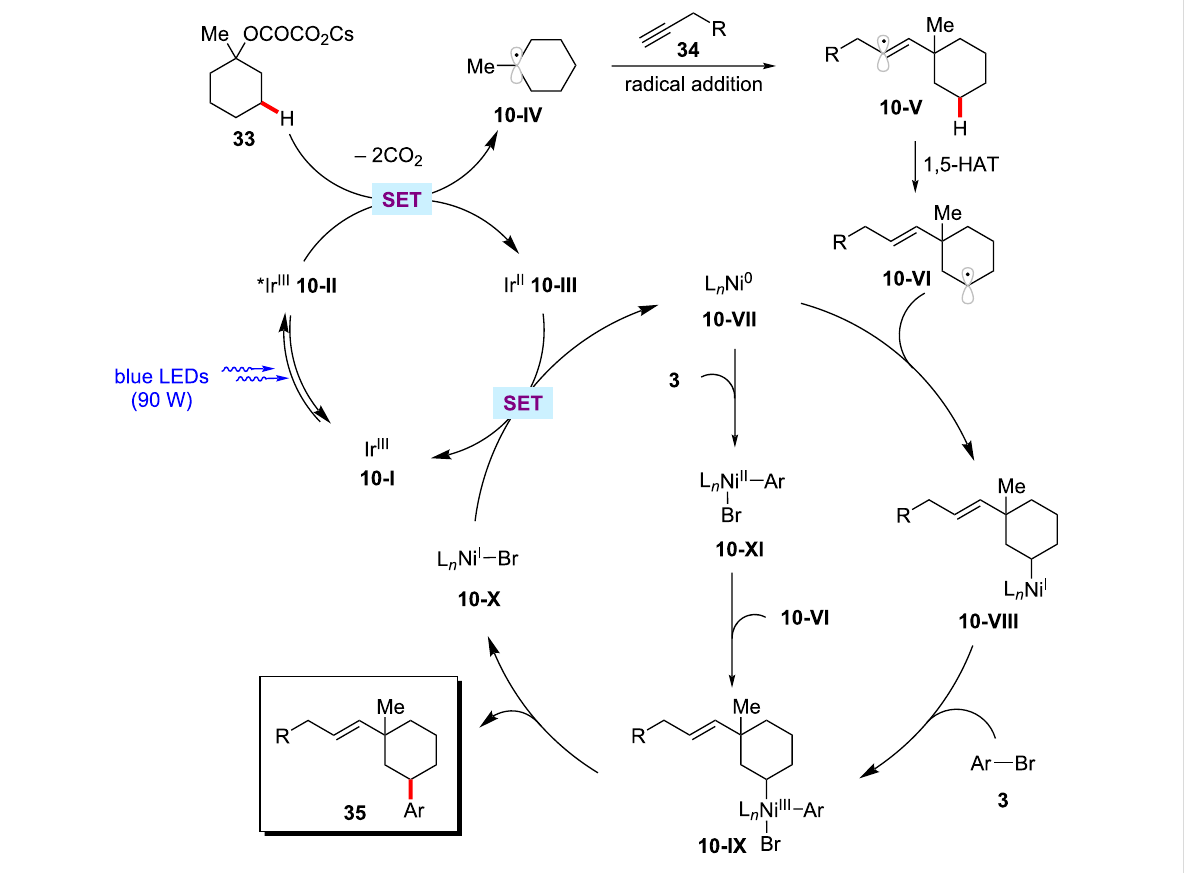
Figure 10: Proposed mechanism for the nickel-catalyzed decarboxylative vinylation/C ‒ H arylation of cyclic oxalates.